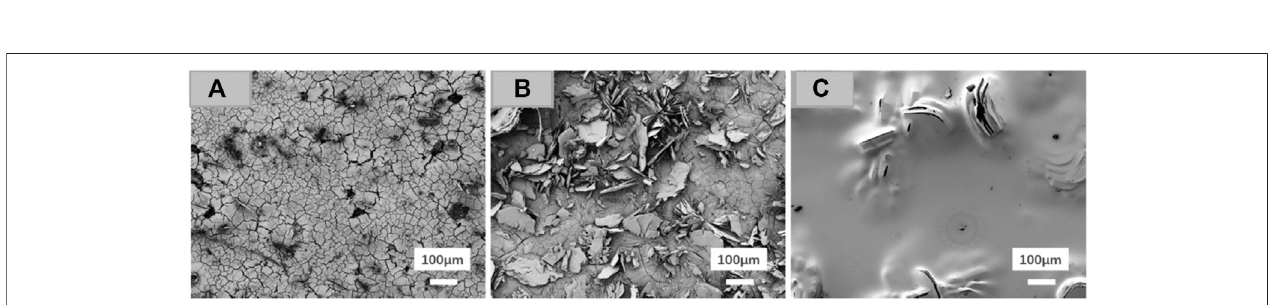
Frontiers in Materials |